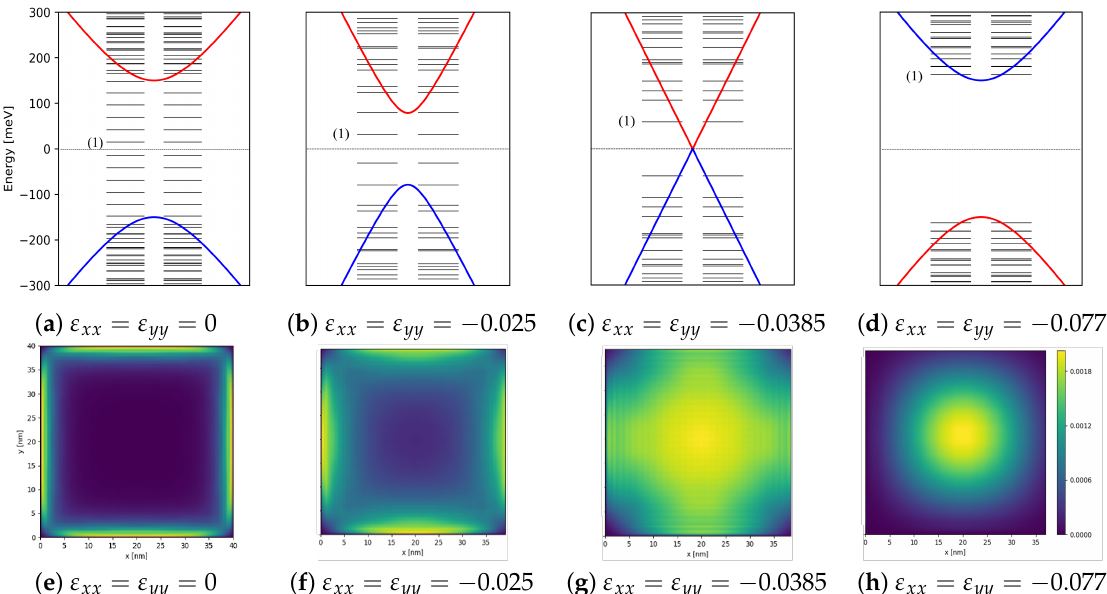
Figure 4. Energy spectra for four different cases of applied strain. ( a ) No strain applied, a topological insulator with a ladder of equally spaced energy levels in the gap of the bulk material is visible. ( b ) Some strain applied, the gap begins to close. ( c ) Dirac cone without edge states. ( d ) Normal insulator without states inside of the bulk gap. We see that by compressively straining the system, a topological phase transition occurs. The first energy level is labelled (1) and spin degenerate eigenval- ues are shown next to each other and plotted together with the energy bands to show edge states inside the energy gap. The black dotted line at zero energy denotes the Fermi level. ( e – h ) Greyscale showing the probability of the first state above the Fermi level in ( a – d ). The parameters used in the diagonalization of the square quantum dot are the topological regime parameters: M = − 150 meV, B = 107 meVnm 2 , and v f = 600